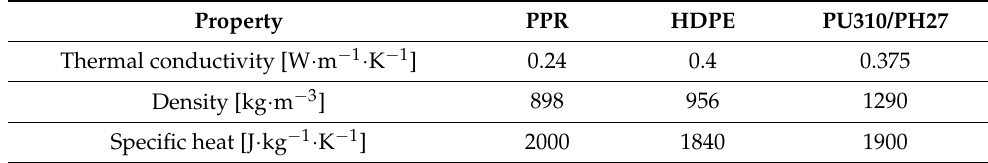
Figure 8. Axis-symmetric finite element model for the analysis of temperature fields ( a ) probe 1 (PPR) and ( b ) probe 2 (HDPE). Table 2. Used materials properties [33,37 – 39].